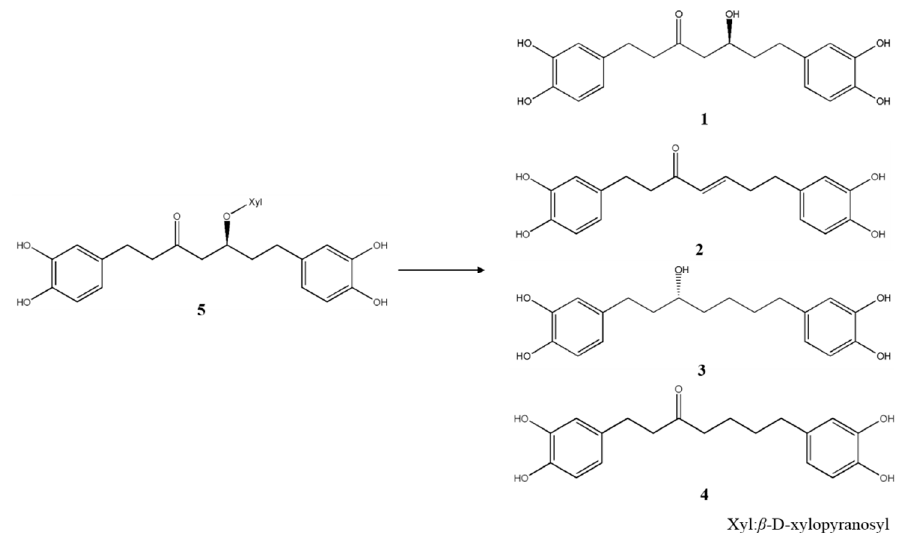
Figure 1. Chemical structure of 1 – 5 and the hydrolysis reaction pathway